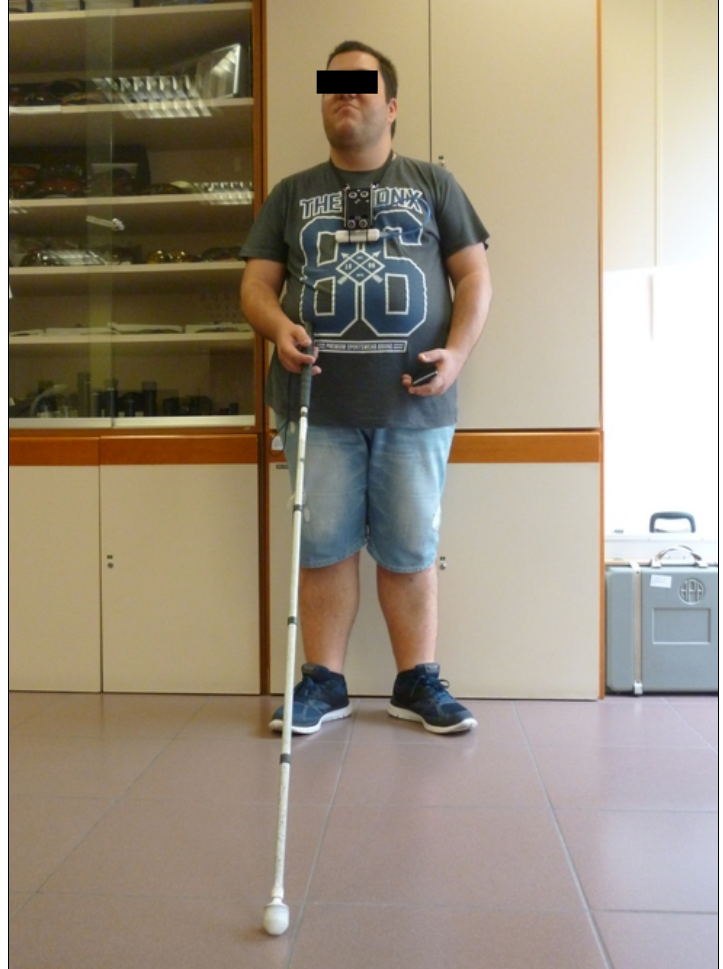
Figure 17. One of the volunteers wearing the eBAT (hanging from the neck) while receiving the short training to learn device